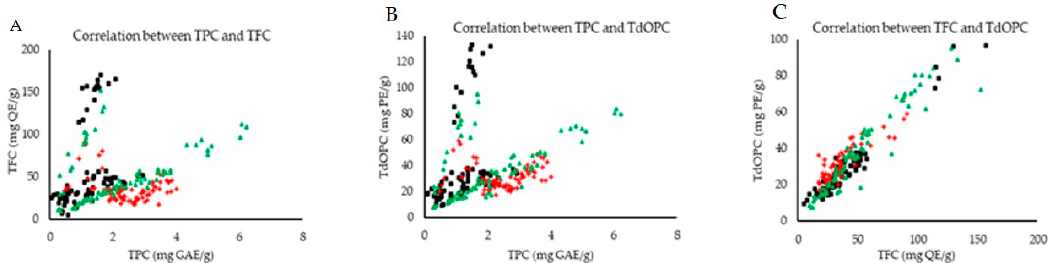
Figure 9. ( A ) Correlation between TPC and TFC. The ρ -value of methanolic extracts ( ■ ) was 0.67, for acidic hydrolysis (+) it was -0.09 and for alkaline hydrolysis ( ▲ ) it was 0.51. ( B ) Correlation between TPC and TdOPC. The ρ -value of methanolic extracts ( ■ ) was 0.67, for acidic hydrolysis (+) it was 0.23 and for alkaline hydrolysis ( ▲ ) it was 0.57. ( C ) Correlation between TFC and TdOPC. The ρ - value of methanolic extracts was 0.95, for acidic hydrolysis (+) it was 0.77 and for alkaline hydrolysis ( ▲ ) it was 0.96.